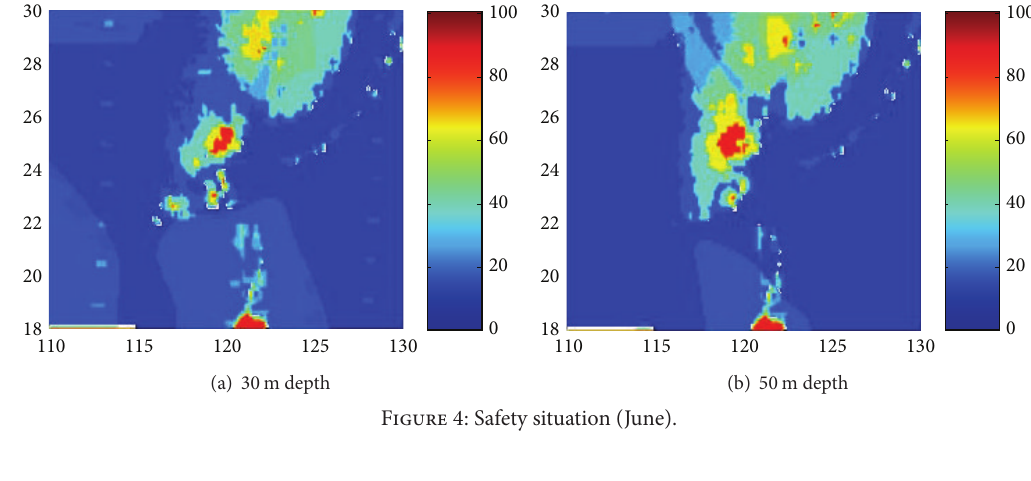
Figure 4: Safety situation (June).